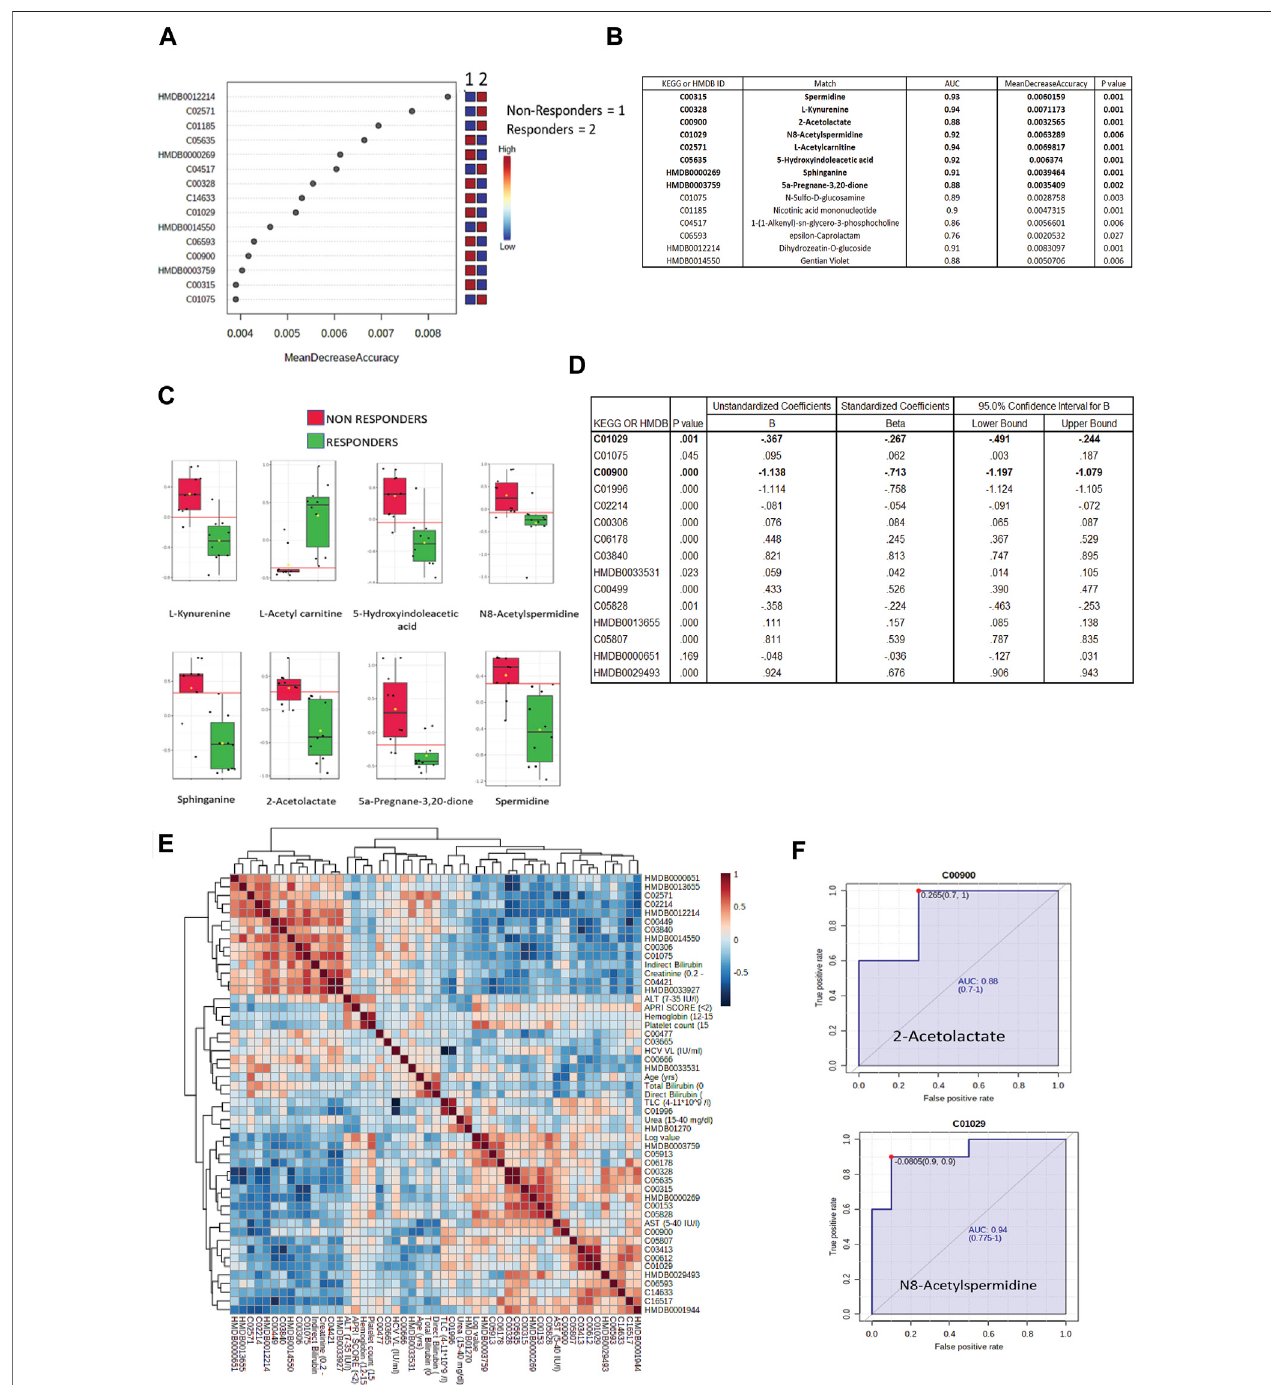
FIGURE 4 | (A) Mean decrease in accuracy plot showing the mean decrease in accuracy of the metabolites along with their expression status Red (cid:1) upregulated andblue (cid:1) downregulatedinDAANonrespondersascomparedtoinDAAresponders. (B) AUCandmeandecreaseaccuracyofmetabolitesinDAANonrespondersas compared to in DAA responders at baseline. (C) Relative abundance (Log normalized) for metabolites showing signi fi cant difference In DAA Non-responders and DAA Responders at baseline based on the metabolome pro fi le of patients. (D) Multivariate linear discriminating analysis documenting Beta factor for all the metabolites signi fi cantlyassociatedwithDAA response at baseline. (E) Correlationplot ofimportantmetabolites and clinicalfeatures. (F) AUROC analysis of2-Acetolactateand N8- Acetyl Spermidine.